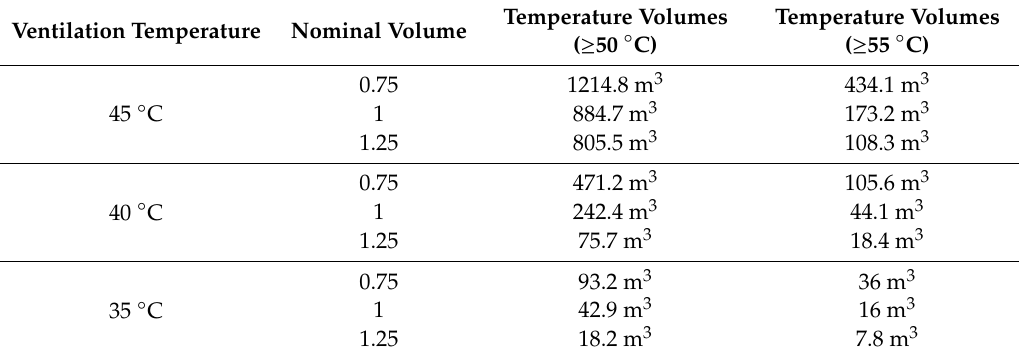
Table 4. Isothermal areas of the high-temperature regions.